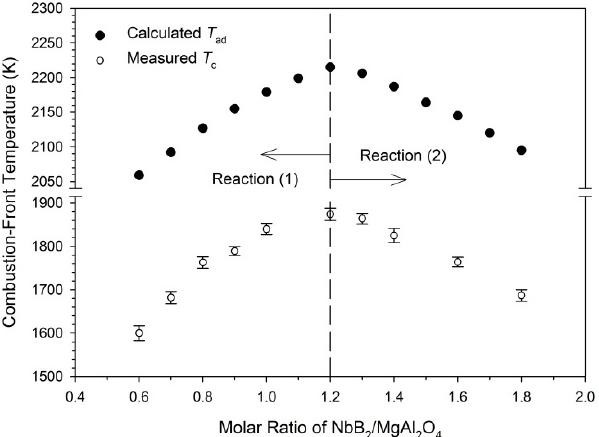
Figure 4. Calculated adiabatic temperatures and measured combustion temperatures of Reactions (1) and (2) as a function of the NbB 2 / MgAl 2 O 4 molar and (2) as a function of the NbB 2 /MgAl 2 O 4 molar ratio.